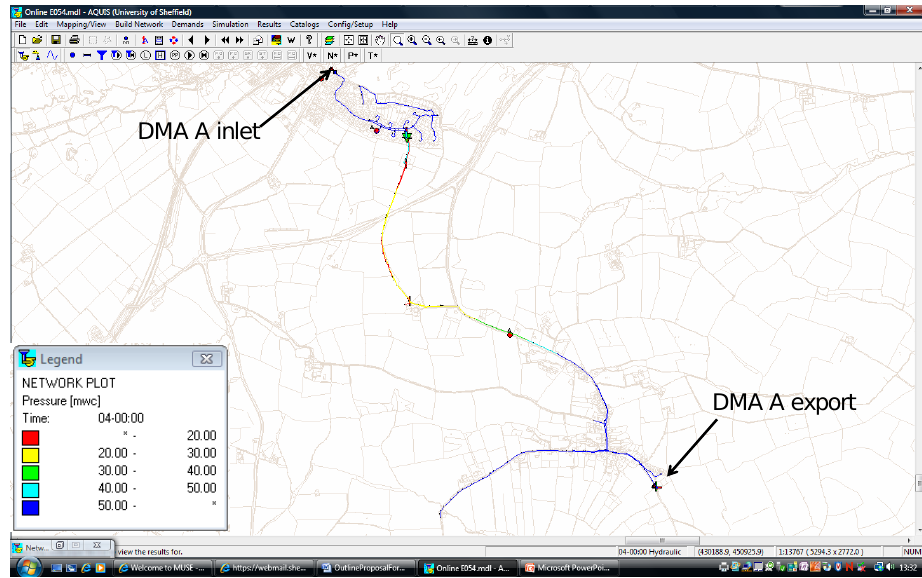
Figure 2. Example DMA network plot with normal pressure overlay.